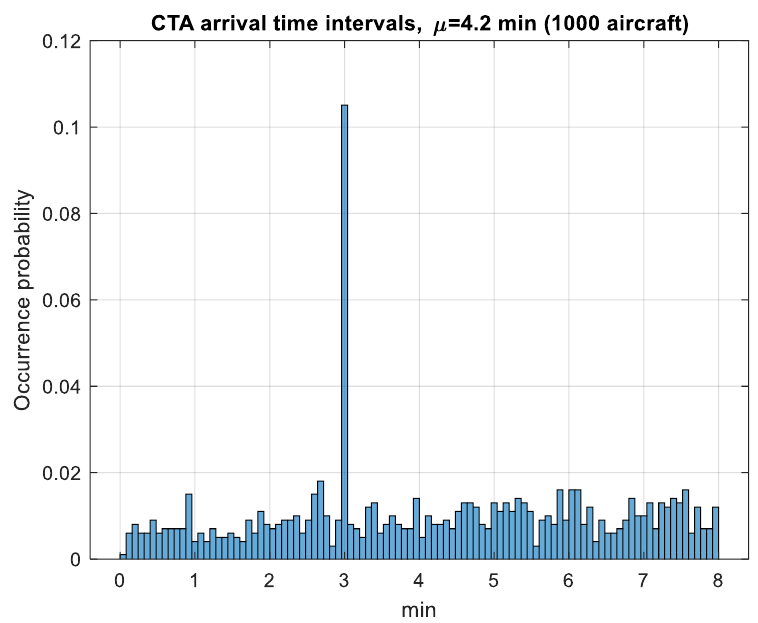
Figure 9 . CTA arrival times distribution. Figure 9. CTA arrival times